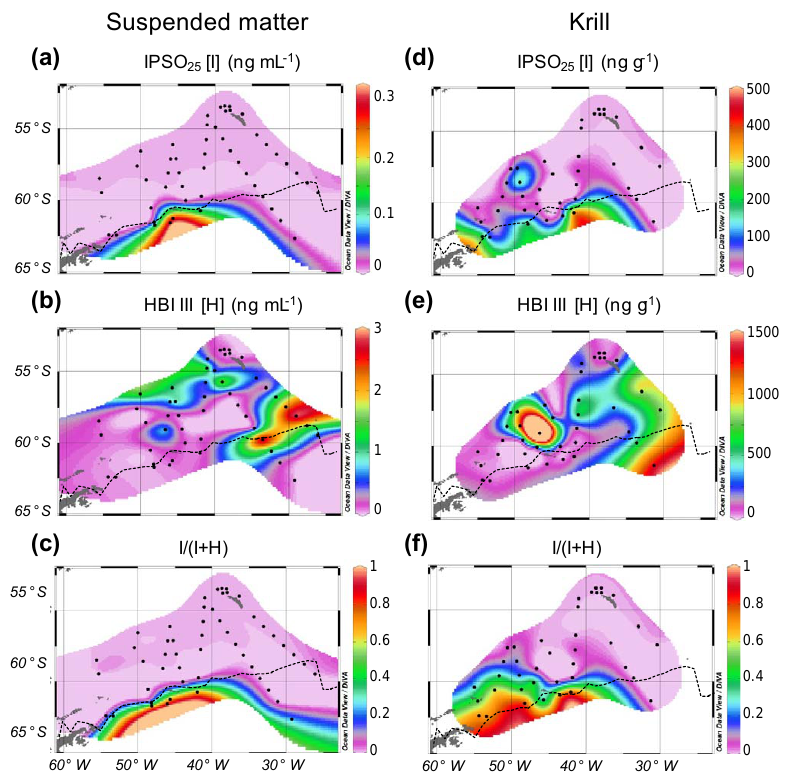
Figure 4. Highly branched isoprenoid (HBI) concentrations in suspended matter from surface waters (left) and whole krill (right): (a, d) IPSO 25 concentrations; (b, e) HBI III concentrations; (c, f) IPSO 25 vs. HBI III ratios. The dashed line represents the mean position of the 15% ice edge during